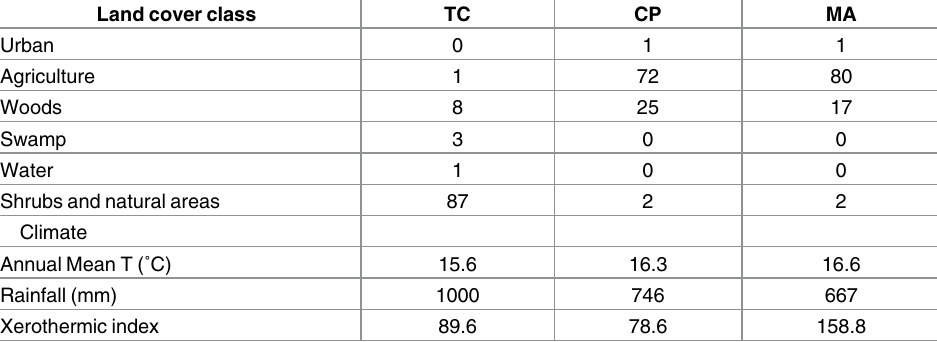
Table 1. Land cover (%) and climatic data (mean annual temperature, mean annual rainfall and xero- thermic index) of the three areas(TC: Tyrrhenian Coast, MA: Maremma, CP: Central plains).